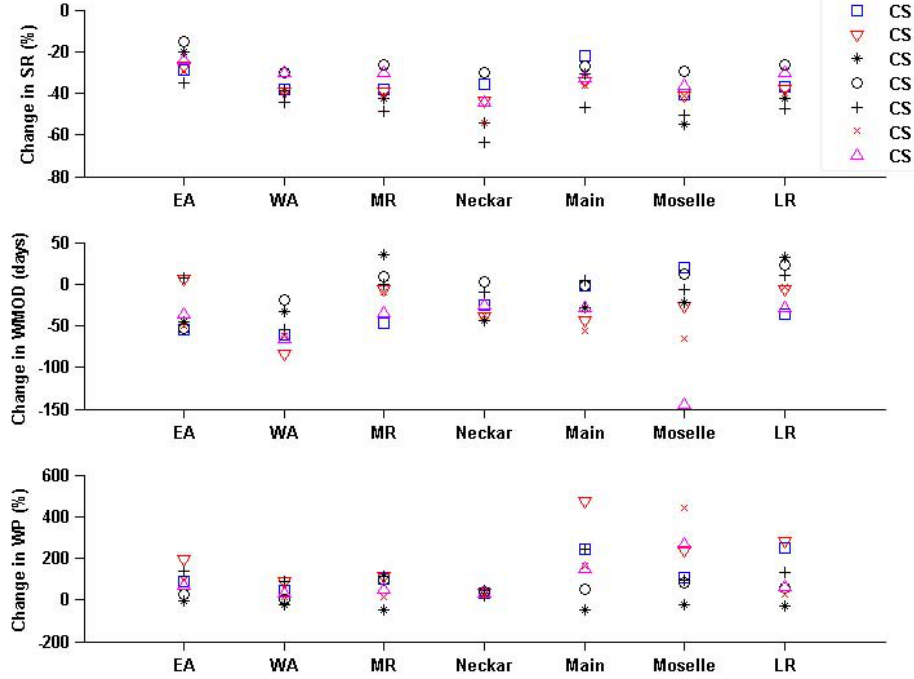
Fig. 6. The relative changes (*) in SR and WP and the changes in WMOD (**) at the outlet of the seven sub-basins estimated from simulated low flows using simulated inputs for the future period 2063–2098 (case 4) compared to simulated low flows using simulated inputs for the reference period 1964–2007 (case 3) from seven climate scenarios (CSs). * (Based on simulated input for future climate – Based on simulated input for current climate)/Based on simulated input for current climate ** Based on simulated input for future climate – Based on simulated input for current